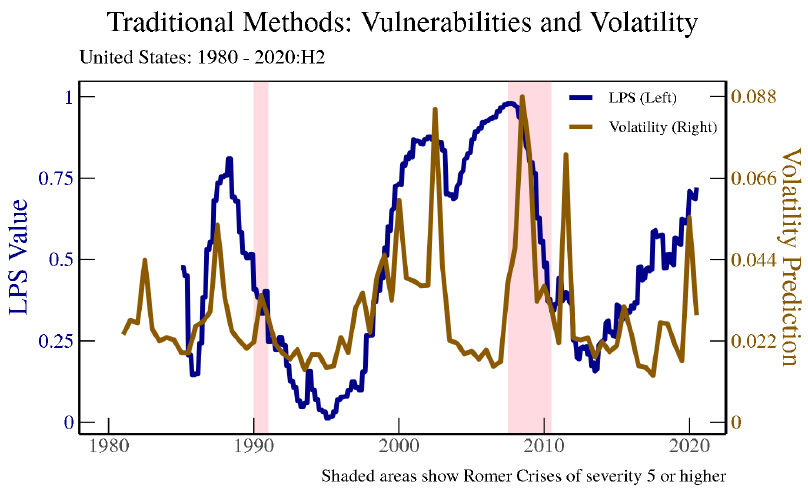
Figure 1. Different Financial Stability Metrics . Note: The figure shows the Lee–Posenau–Stebunovs (LPS) vulnerability index for the United States (lfrom Lee et al. (2020)) and predictions from a realized volatility model calculated from US stock markets (similar to the measure used in Duprey et al. (2017) and Danielsson et al. (2018)). The shaded regions indicate periods of crisis severity 5 or higher according to Romer and Romer (2017). These two metrics illustrate how current quantitative indicators of financial stability cannot provide consistent information regarding the onset of crisis states or the length of